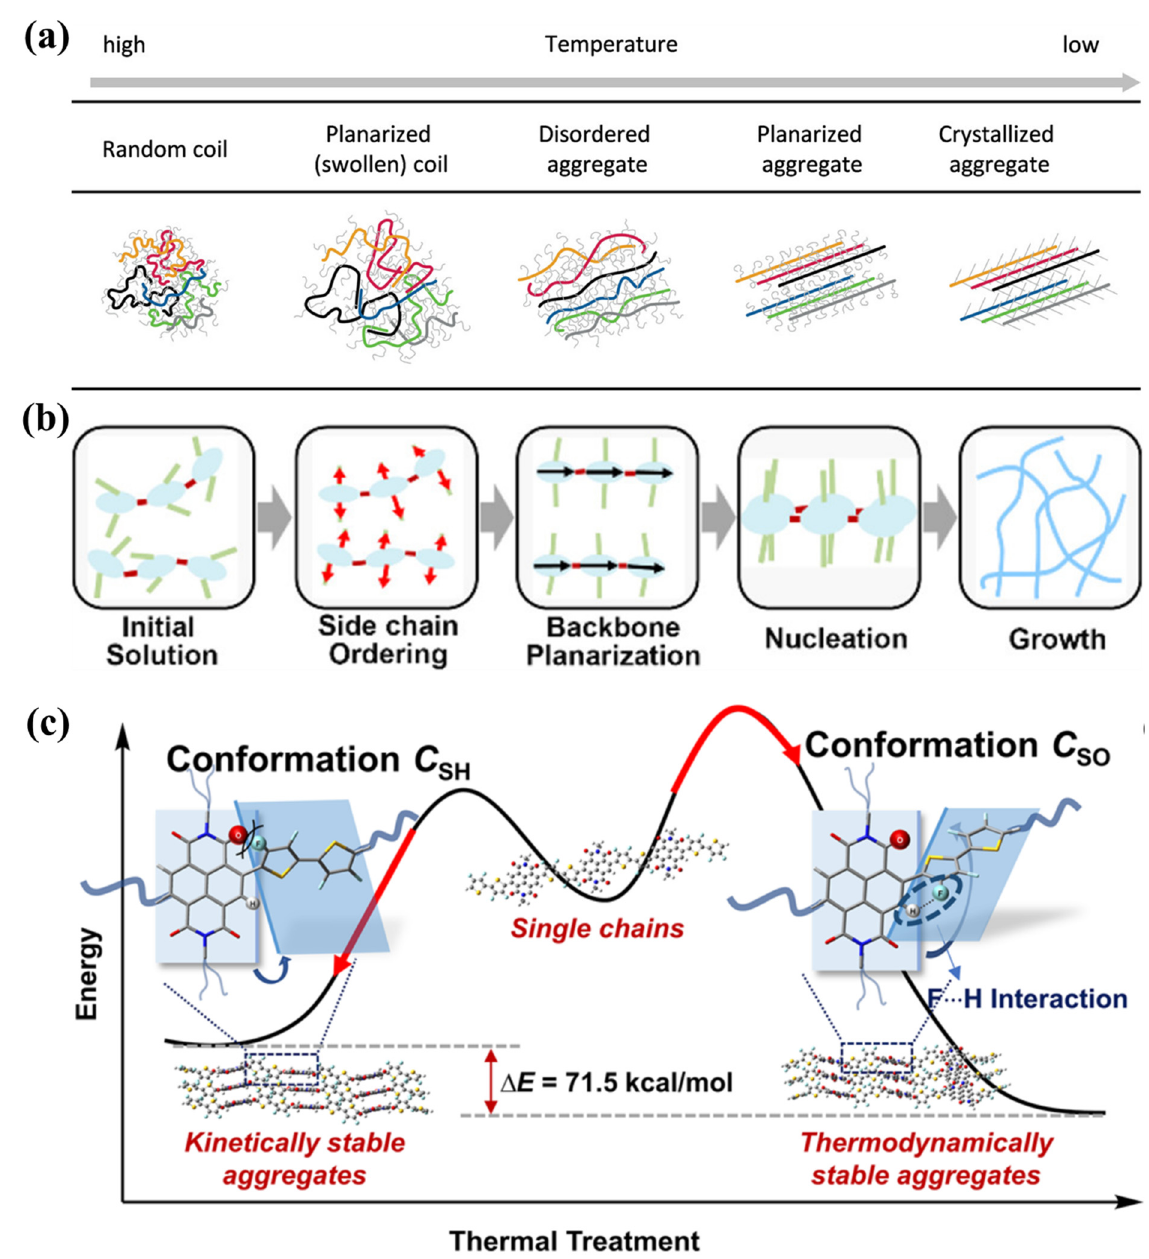
Figure 4. ( a ) Schematic diagram of the evolution of conjugated polymer chain conformations in solution during the cooling process, which was adapted from reference [104] with permission from Copyright 2017 American Chemical Society. ( b ) Schematic diagram of the evolution of PNDI chain conformations in the BN solution during the aging process, which was adapted from reference [69] with permission from Copyright 2021 American Chemical Society. ( c ) Schematic diagram of the potential energy and the corresponding chain conformations of PNDI-4F2T before and after thermal treatment, which was adapted from reference [106] with permission from Copyright 2021 American Chemical Society.